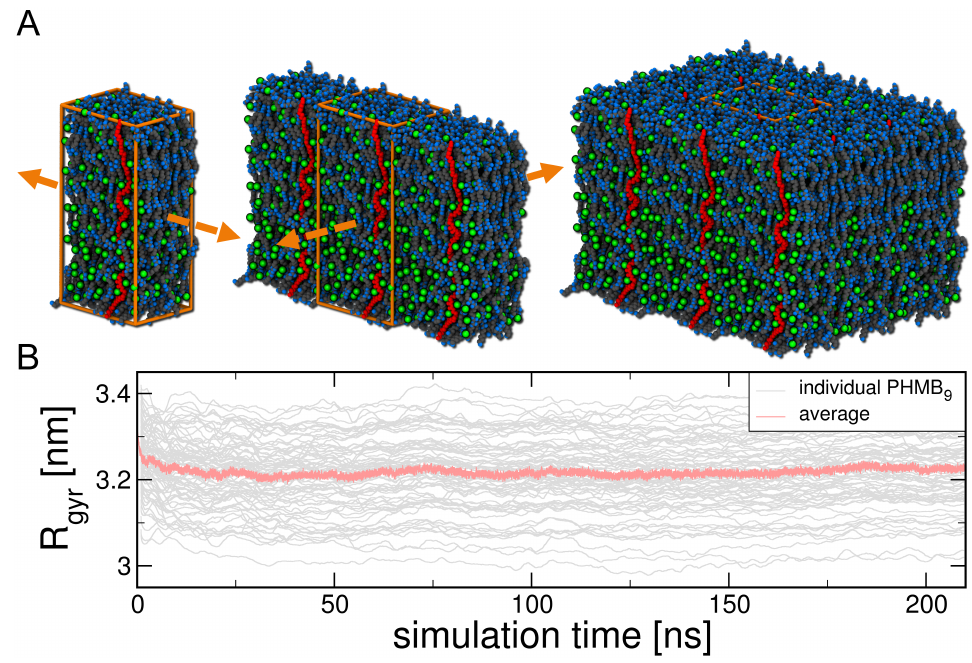
Figure 2. ( A ) (left) Periodic brush-like structure after 200 ns of relaxation MDS (N: blue; C: grey; H: hidden for clarity; Cl-: green). One PHMB 9 oligomer is colored in red to visualize the parallel and extended arrangement. The orange arrows illustrate replication of this building block by the spatial X (left) and Y (middle) dimensions. The resulting surfaces (right), with different end-groups are subjected to the simulation of water contact angles. ( B ) R gyr of each individual PHMB 9 in our brush-like block is plotted over time with a running average of 2 ns window length. It can be seen that the radii of gyration for all individual oligomers converge quickly and that the structure remains stable. The average R gyr of about 3.2 nm is significantly larger than that for isolated molecules in